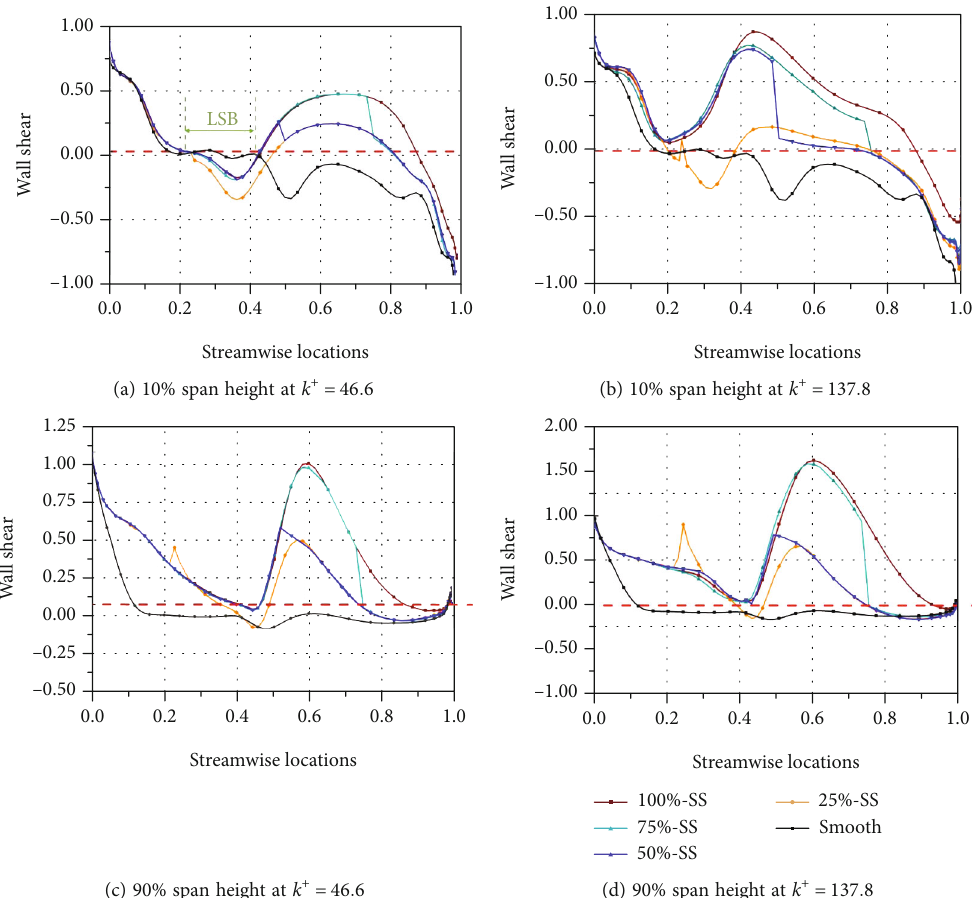
Figure 21: Skin wall shear distribution for the di ff erent roughness locations at k + = 46 : 6 and